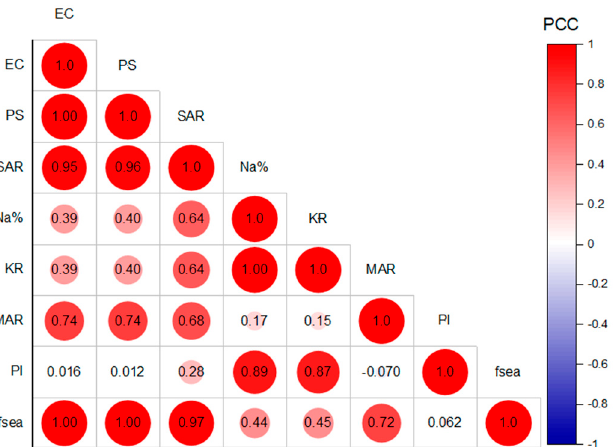
Figure 10. Correlation map of the SWI index ( f sea ) and irrigation hazard indices (EC, PS, SAR, Na%, KR, MAR, and PI) (CC is the Pearson correlation coe ffi cient).